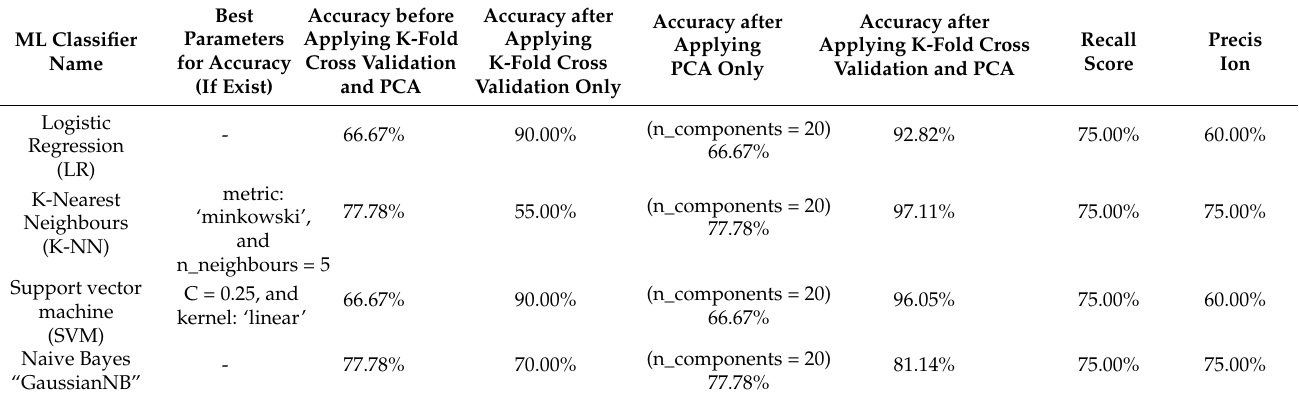
Table 3. Performance analysis of different classifiers on all extracted